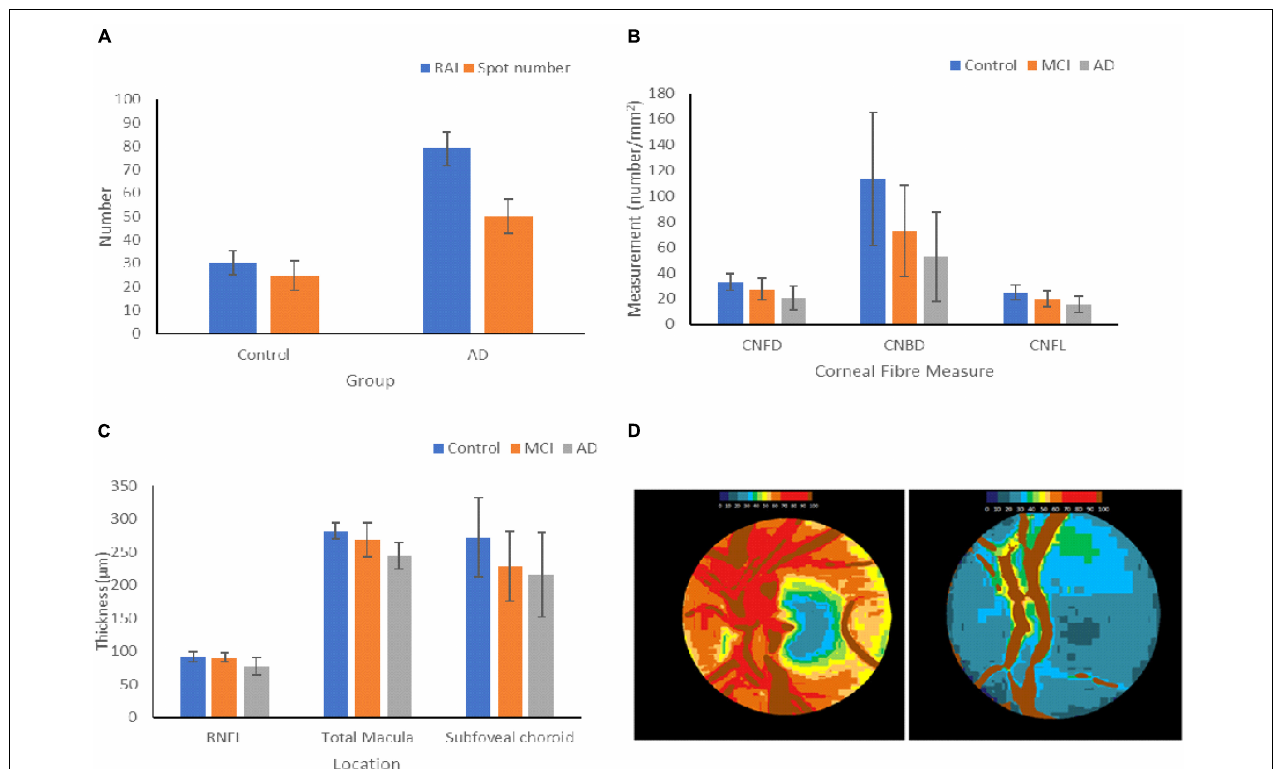
FIGURE 3 | Changes in ocular biomarkers throughout AD progression. (A) A β Deposition in the retinas of HCs and AD patients. The retinal amyloid index is a quantitative measure of the increase in curcumin fluorescence, and the spot number shows the number of positive curcumin depositions. The graph shows the mean ± standard deviation (Petrella et al., 2019). (B) Measurements of the changes in the corneal nerve fibers of HCs and patients with MCI and AD. The graph shows the mean ± standard deviation (Ponirakis et al., 2019). (C) Changes in thickness of the RNFL, macula, and subfoveal choroid in HCs, MCI, and AD patients. The graph shows the mean ± standard deviation (Bulut et al., 2016; Kim and Kang, 2019). (D) Optic nerve pallor of the left papilla in HC (left) and a patient with AD (right). The images show the changes in hemoglobin absorbance in each papilla, resulting in pallor. Lower hemoglobin absorbances appear blue, and higher absorbances appear in red (Bambo et al., 2015). RAI = retinal amyloid index, CNFD = corneal nerve fiber density, CNBD = corneal nerve branch density, CNFL = corneal nerve fiber